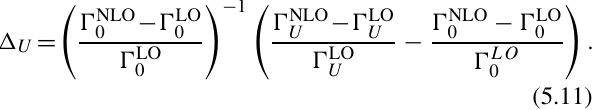
Fig. 8 Comparison between SARAH (blue) and SPheno (red) for the loop-induced decays of the neutralinoand gluino. On the left, the partial widths are shown. Blue lines are obtained with SARAH , red lines with SPheno . On the right, the relative difference between the codes as a function of the mass splitting is shown (not (cid:10)(cid:3) from Eq. (5.10)). In the